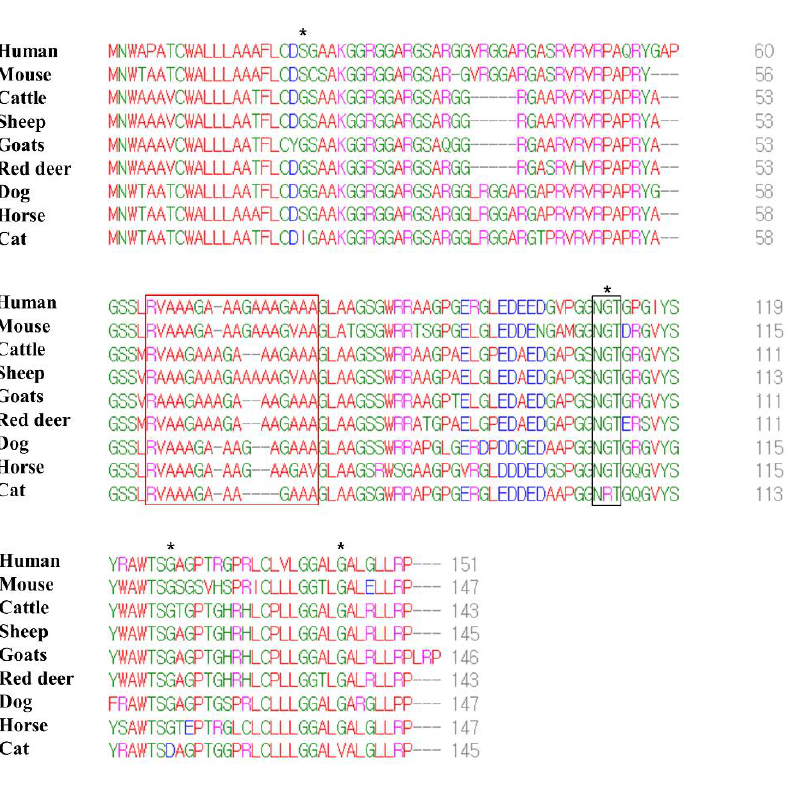
Figure 2. Analysis of the mRNA secondary structure of the feline SPRN gene according to haplo- types in the feline SPRN polymorphisms. ( A ) Minimum free energy and mRNA secondary structure of the feline SPRN gene with the CCC haplotype (1 – 215 nt). ( B ) Minimum free energy and mRNA secondary structure of the feline SPRN gene with the ACC haplotype (1 – 215 nt). ( C ) Minimum free energy and mRNA secondary structure of the feline SPRN gene with the CCC haplotype (230 – 580